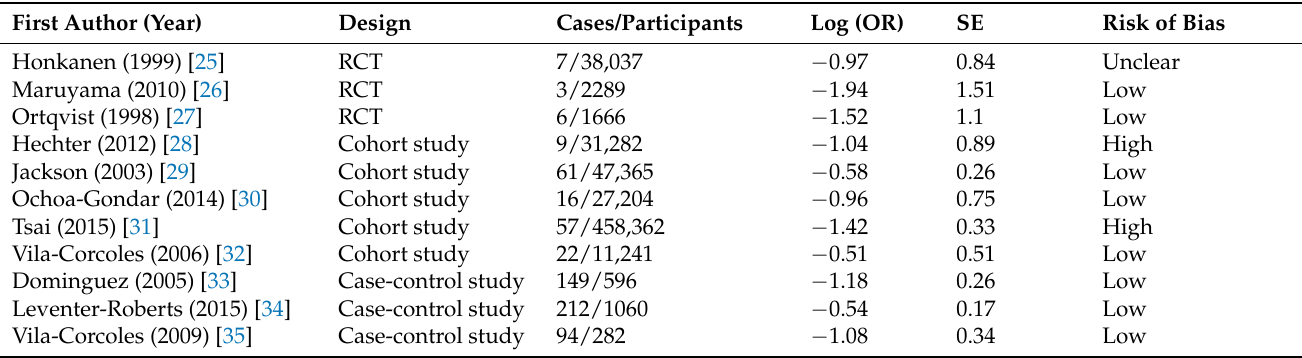
Table 1. Characteristics of included studies in the meta-analysis of the efficacy and effectiveness of pneumococcal polysaccharide vaccine (PPV23) vaccination against invasive pneumococcal disease (IPD) in elderly patients.